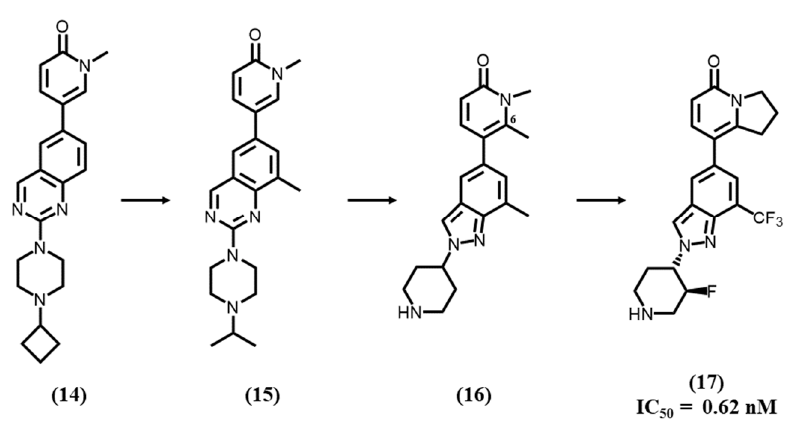
Figure 5. SAR studies with pyridone derivatives.